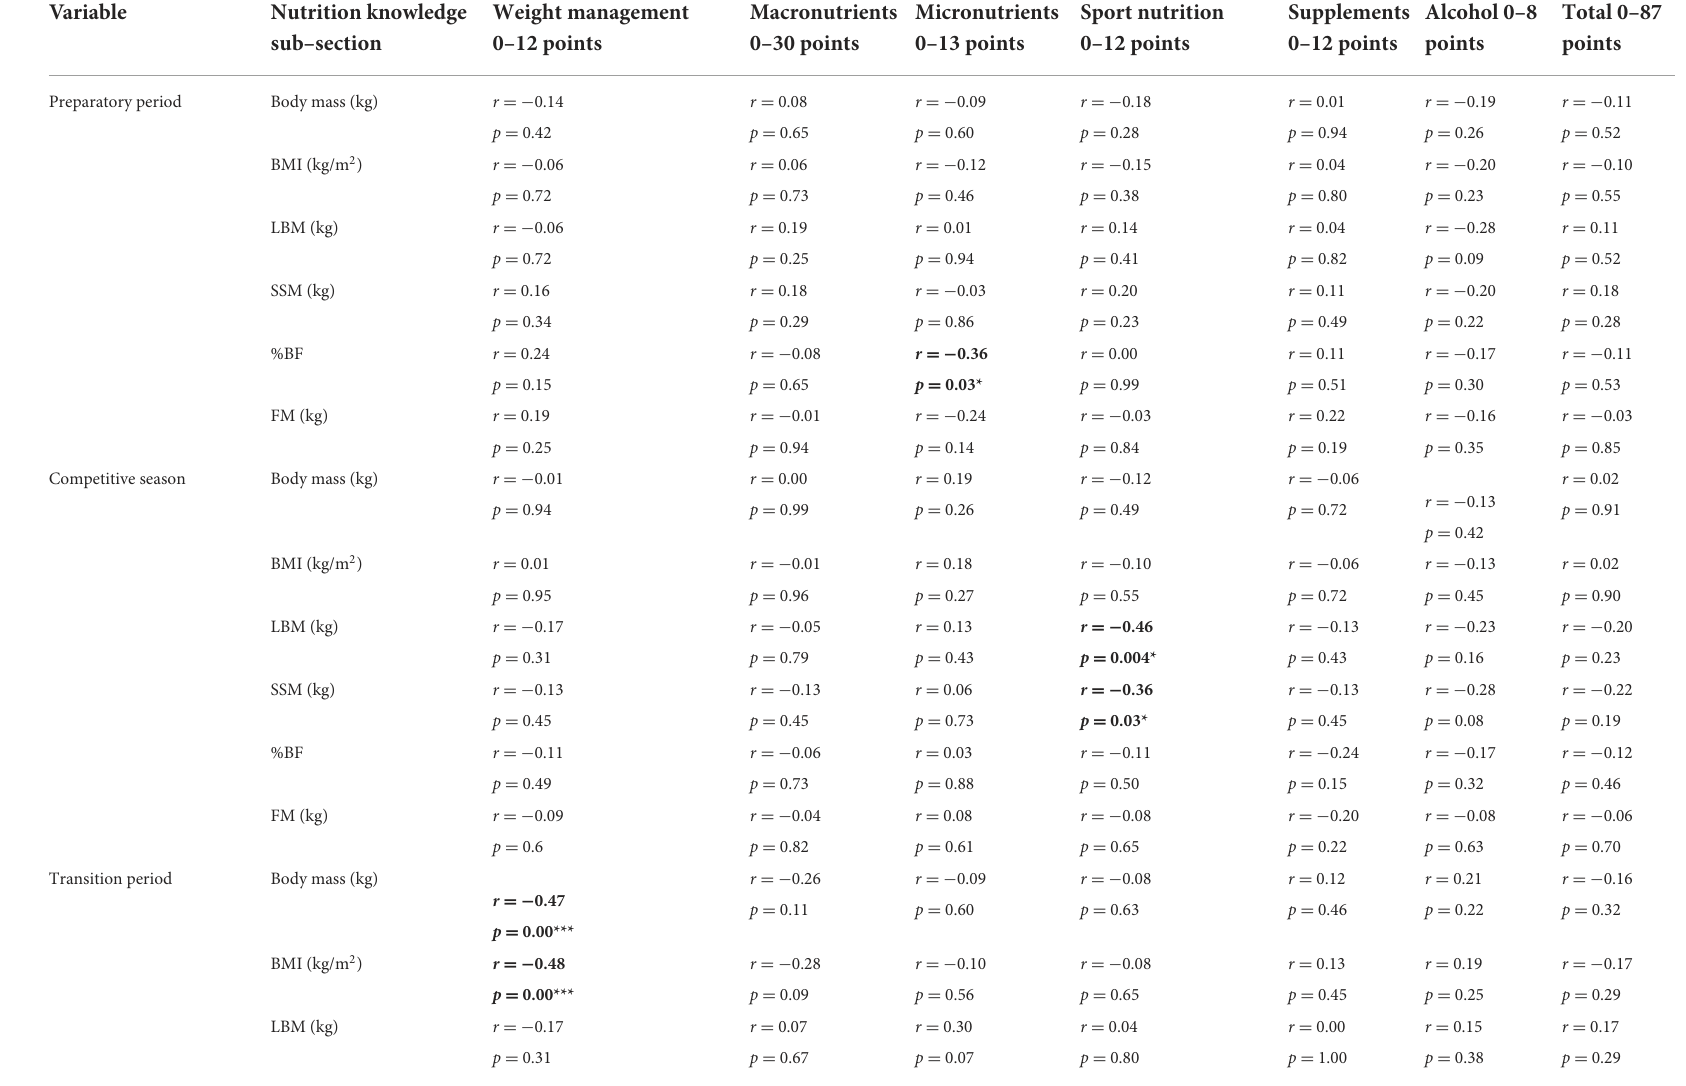
TABLE 2 The strength of correlation of differences between maximum and minimum body composition measurements and scores on the nutrition knowledge assessment expressed by Spearman’s R’ correlation